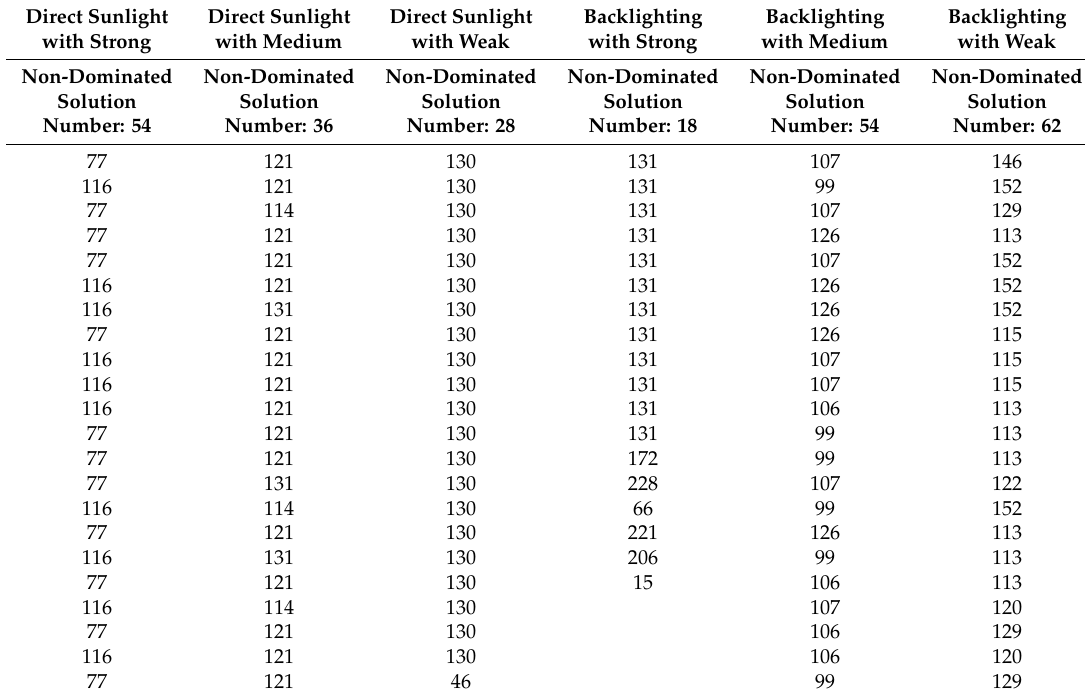
Figure 17. Comparison of the results of image segmentation under backlighting under the medium illumination condition. Table 7. Thresholds of the non ‐ dominated solution set under six illumination conditions using the ARMM ‐ AHS method.